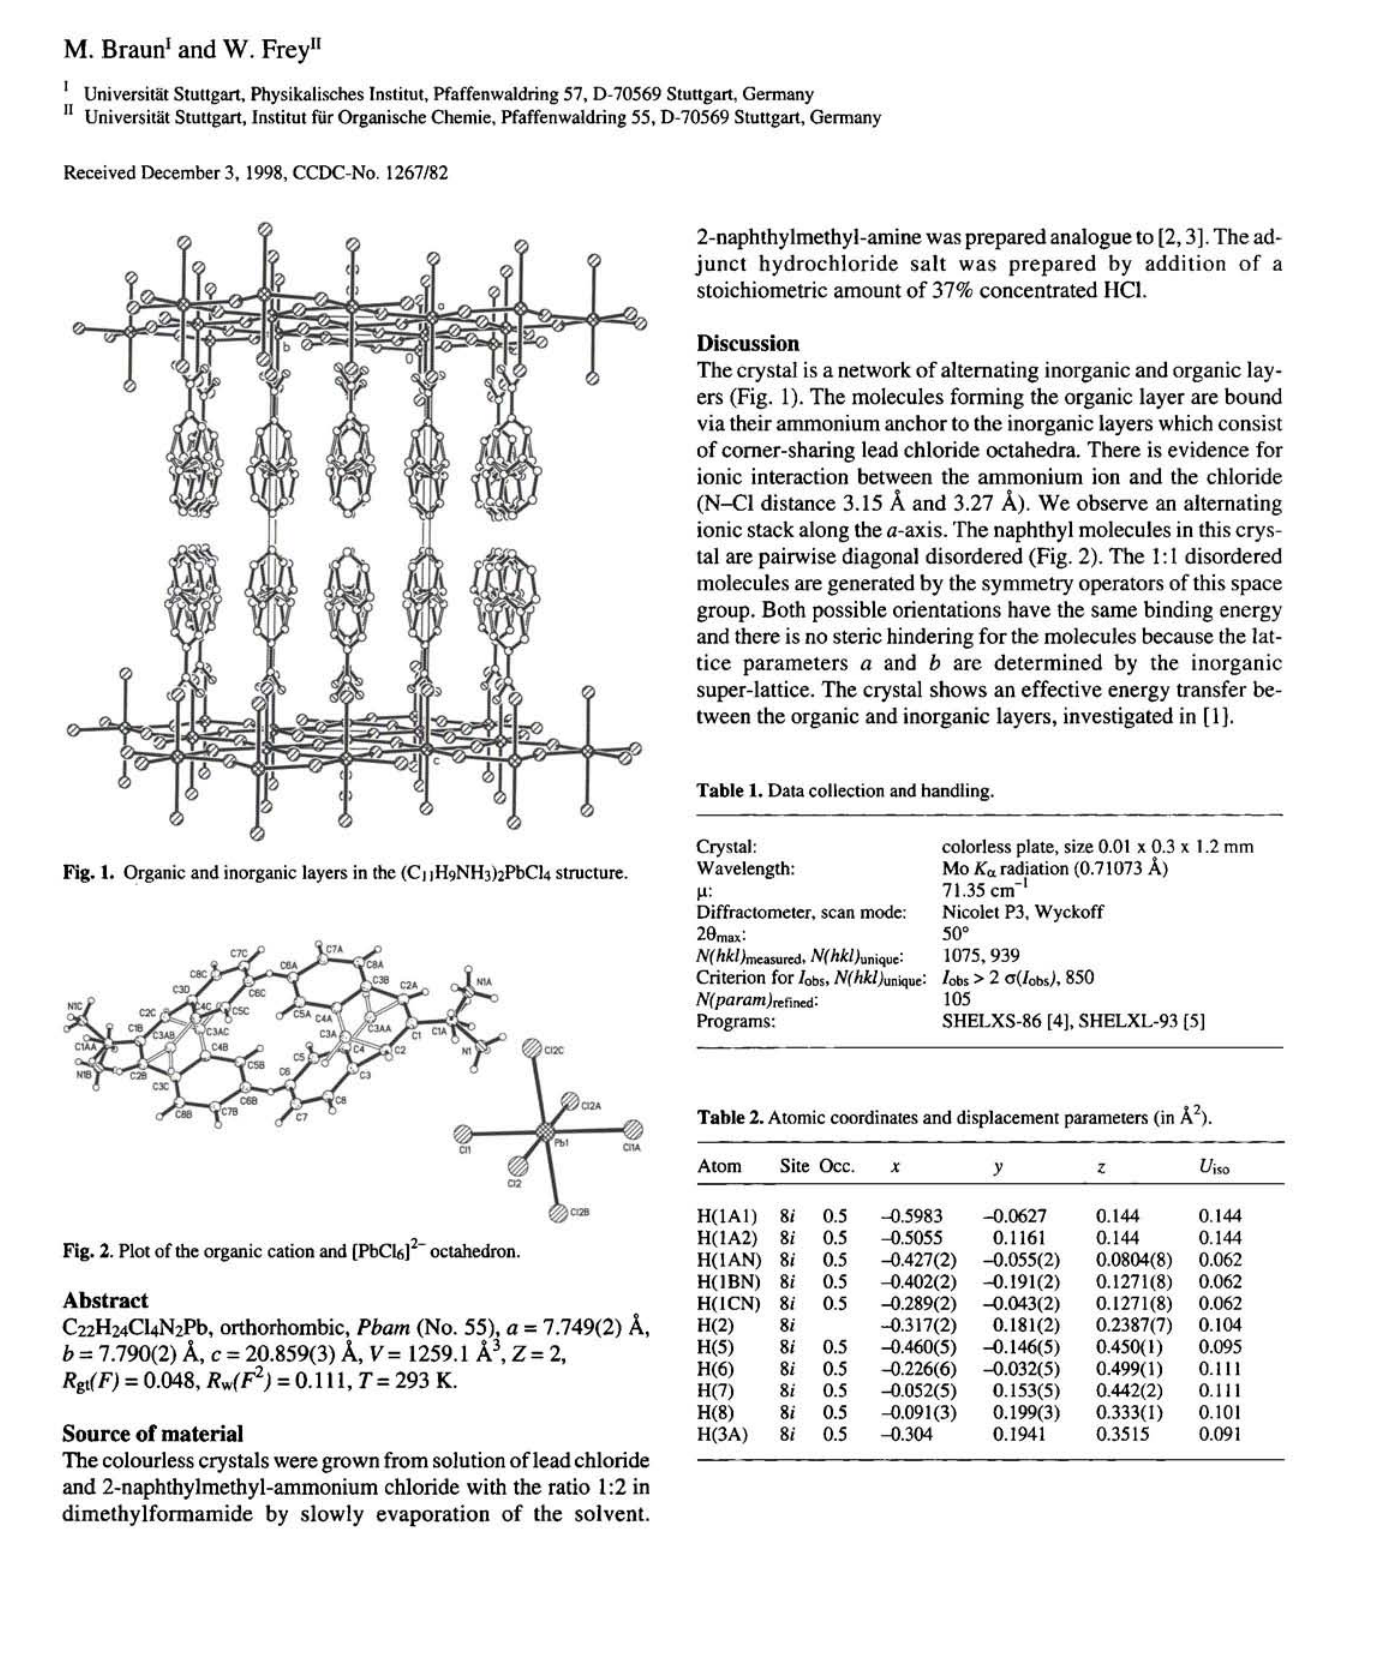
Table 2. Atomic coordinates and displacement parameters (in Â 2 ).